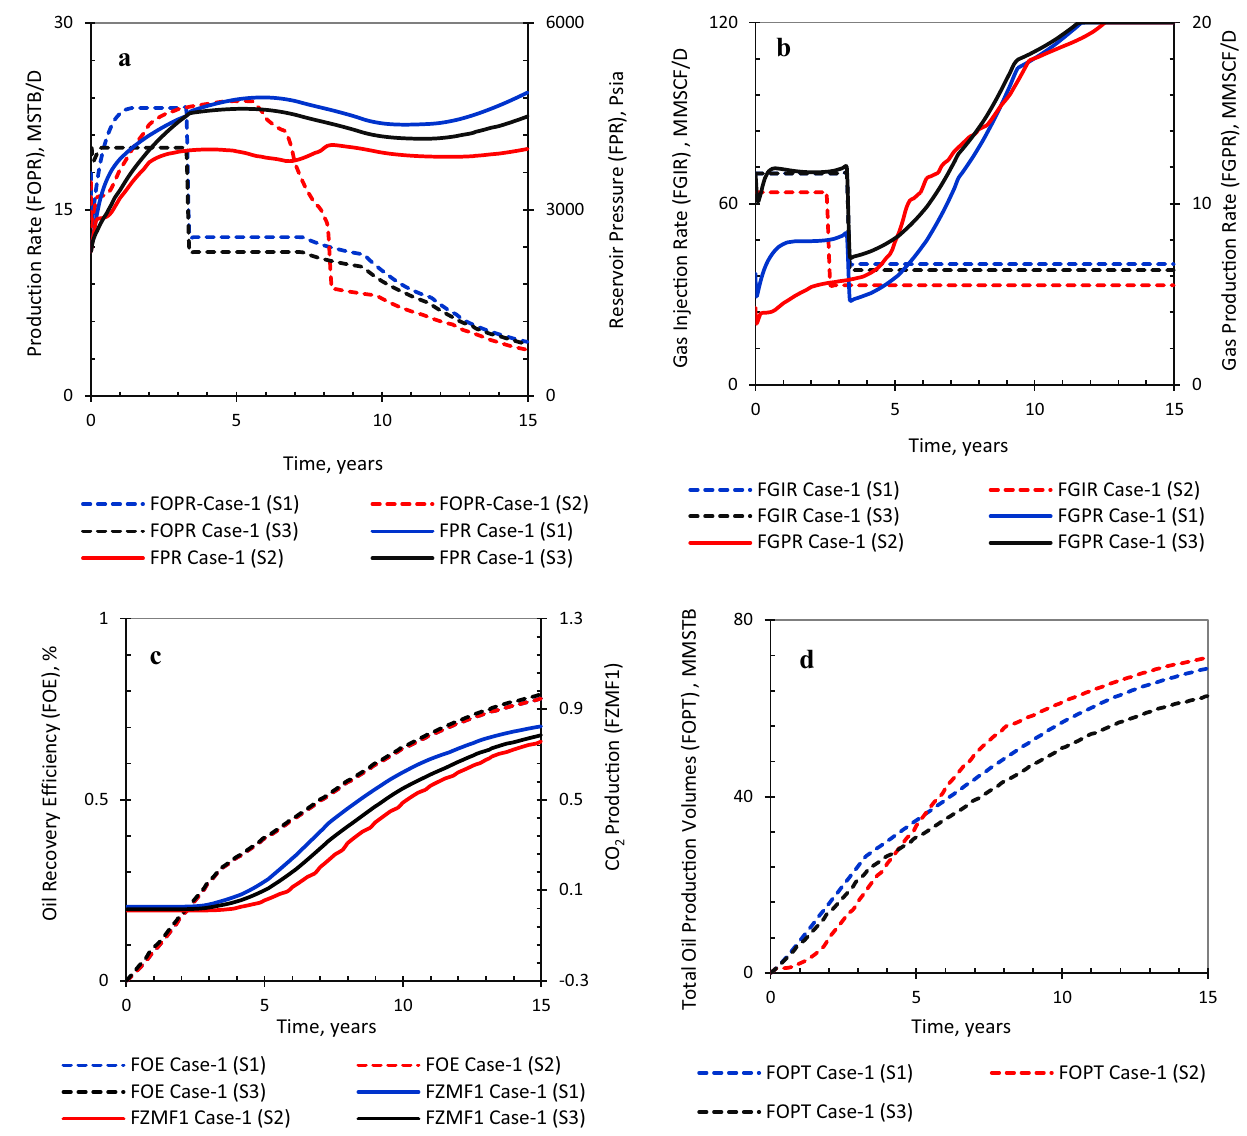
Fig. 10 Comparison between a FOPR & FPR, b FGIR & FGPR, c FOE & FZMP, and d FOPT of S1, S2, and S3